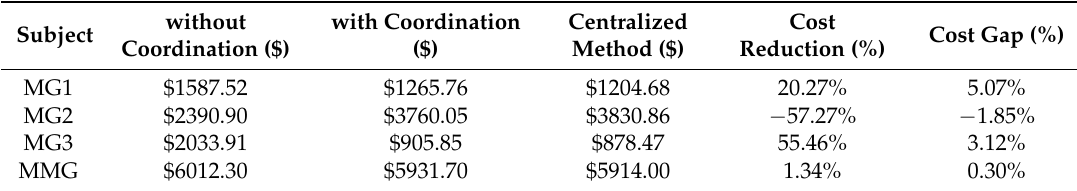
Table 6. A summary of the results comparison with penalty term.